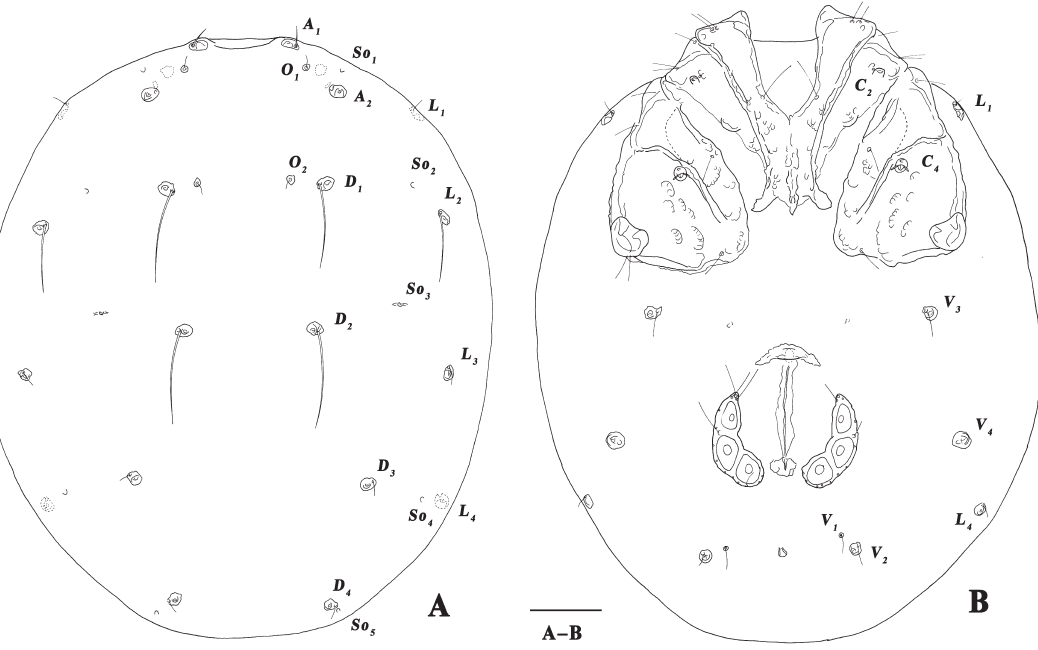
Fig. 2. Atractides ( Atractides ) biprojectus Zhang, Li & Guo sp. nov. A–B . Paratype, ♀ (GUGC, Slide No. QH-HY-2020071705). A . Idiosoma, dorsal view. B . Idiosoma, ventral view. Scale bar = 100